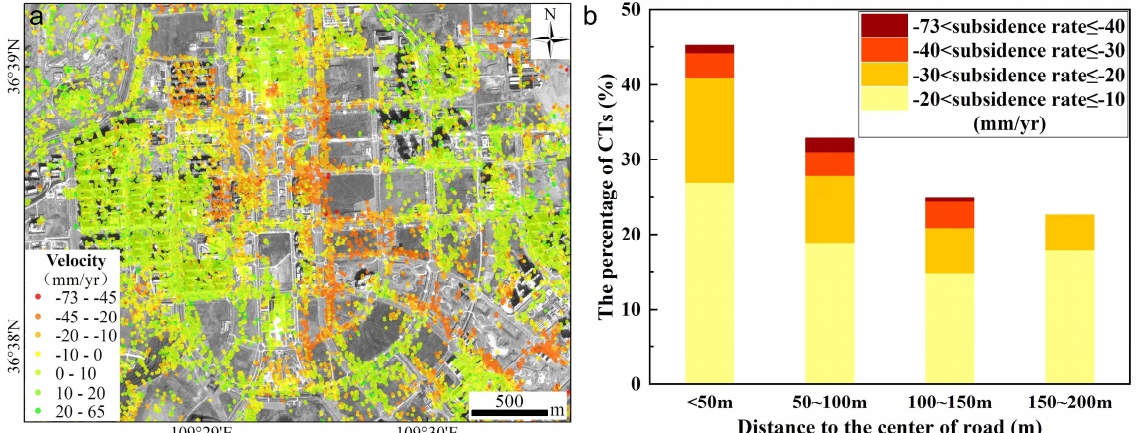
Figure 12. Relationship between the land subsidence and road networks. ( a ) Enlarged deformation map of the area in the rectangle in Figure 11. The background is a panchromatic ZY-3 image. ( b ) Statistics of the CTs at different distances from the road.